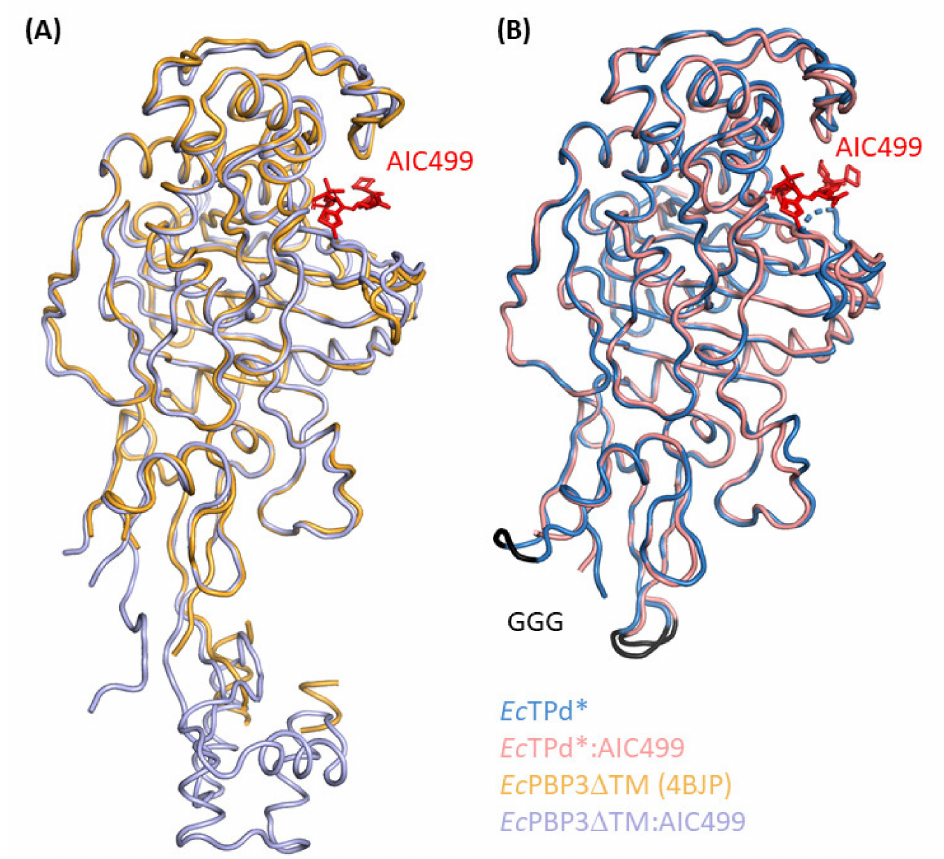
Figure 3. X-ray structures of Ec PBP3 determined in the absence and presence of AIC499 (red stick model). ( A ) The published apo- Ec PBP3 ∆ TM structure (PDB entry 4BJP [13], gold) is used for superposition with the AIC499-complexed Ec PBP3 ∆ TM (blue, this study). ( B ) The structure of apo- Ec TPd* is shown in dark blue, while the complex with AIC499 is colored salmon. The GGG linkers replacing the removed segments are shown in